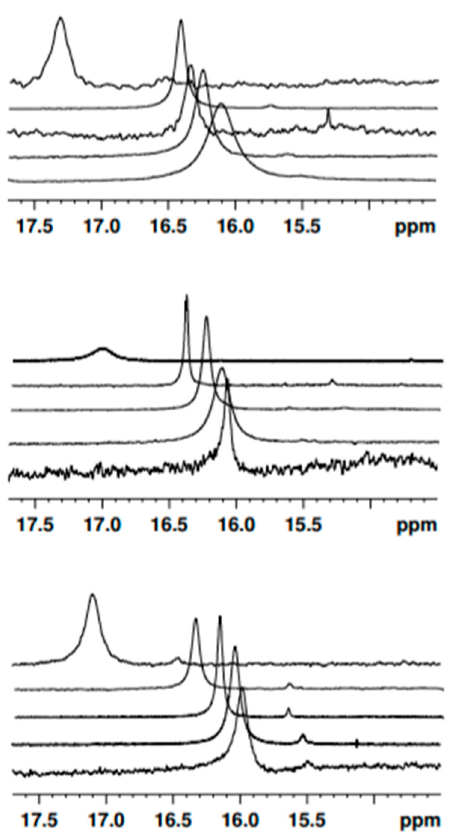
Figure 9. 1 H-NMR spectra of 1 ( up ), 2 ( center ), and 3 ( down ) in (from top to bottom) toluene- d 8 , dimethylsulfoxide- d 6 , acetonitrile- d 3 , dichloromethane- d 2 , and chloroform- d 1 .